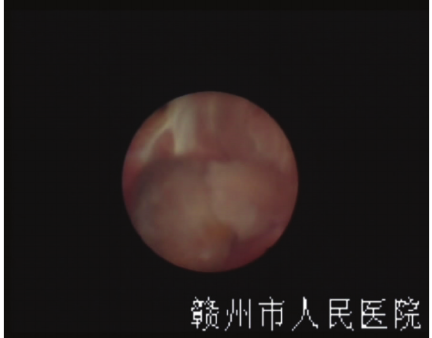
Figure 1: Stone in the cavity of seminal vesicle.